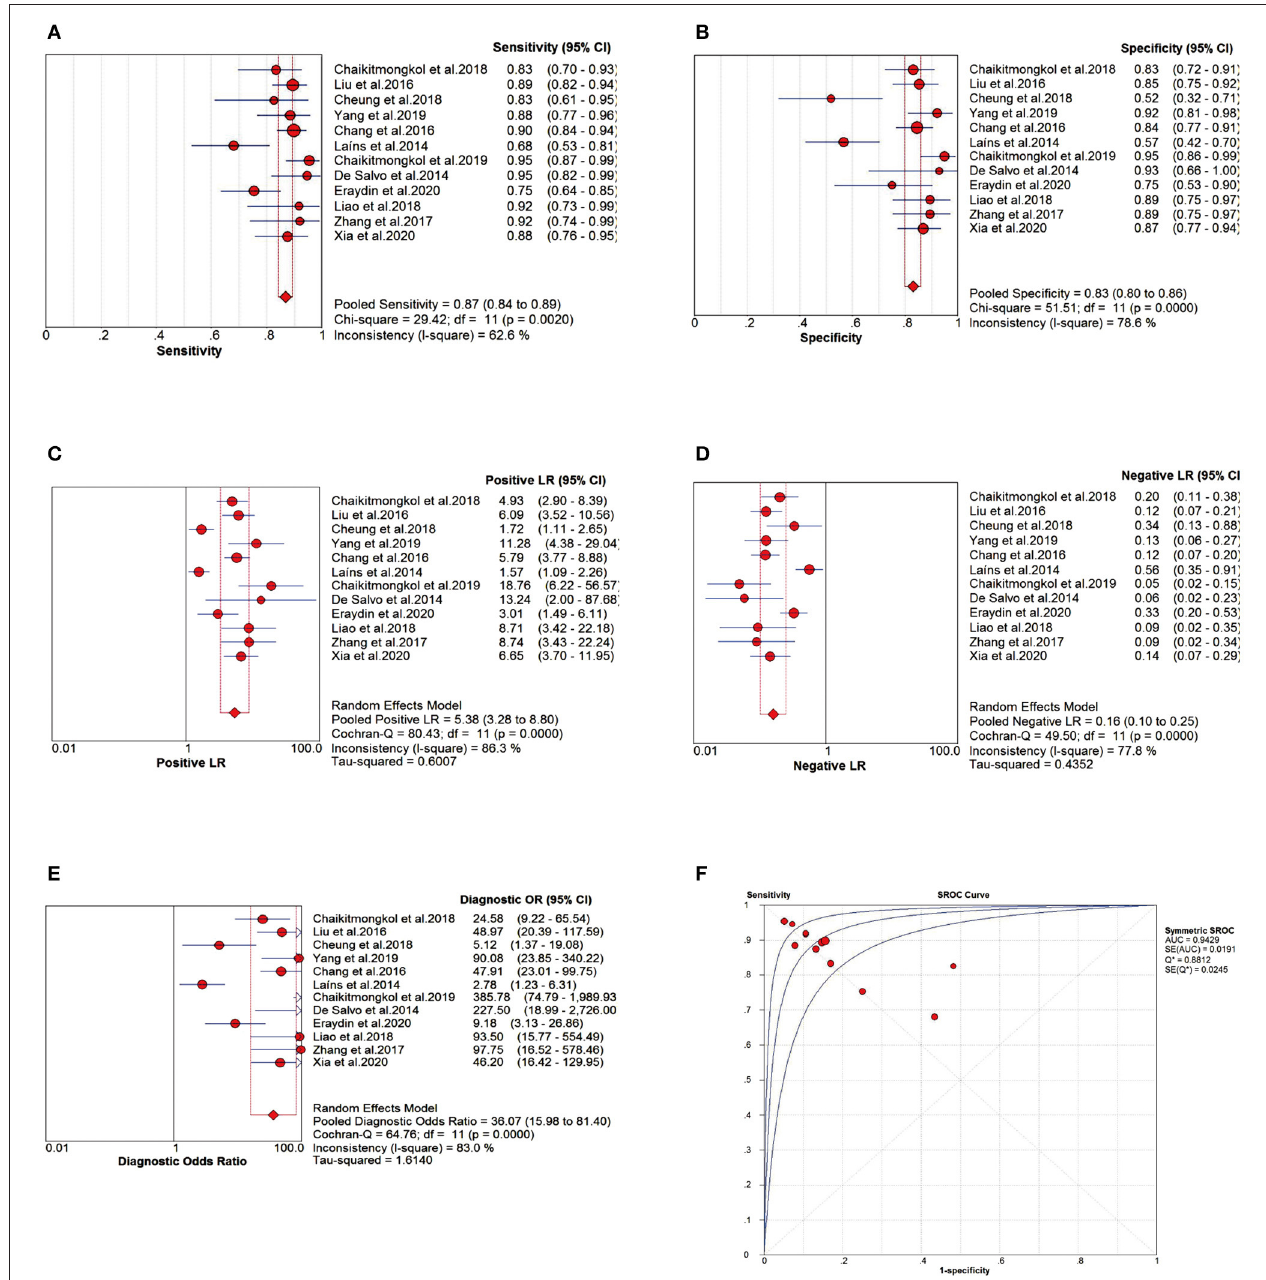
FIGURE 4 | Meta-analysis forest plots of the relevant effect sizes. (A) The pooled sensitivity (Se). (B) The pooled specificity (Sp). (C) The pooled positive likelihood ratio (PLR). (D) The pooled negative likelihood ratio (NLR). (E) The pooled diagnostic odds ratio (DOR). (F) The summary receiver operating characteristic curve (sROC) and area under the curve